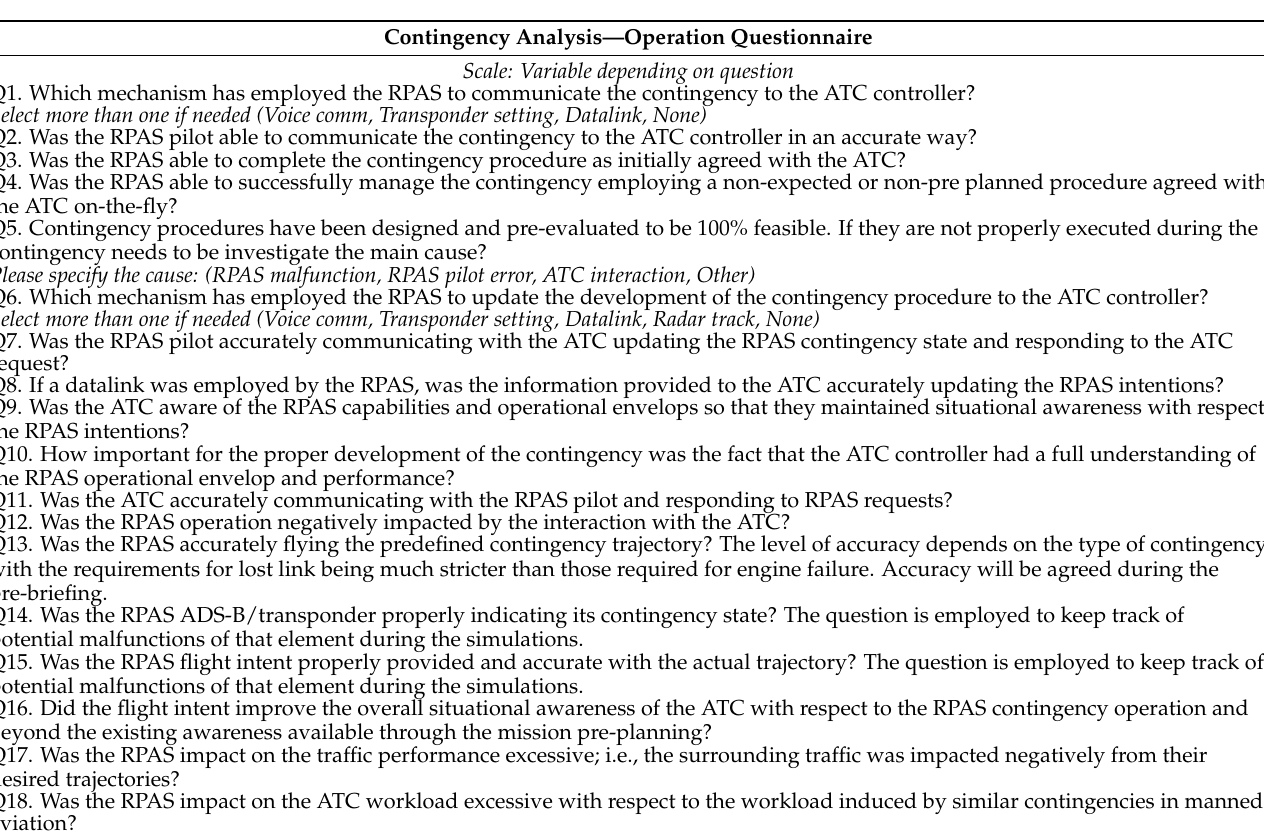
Table 8. Contingency analysis: operation